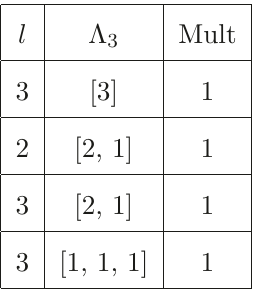
Table 2 . Results for n = 3 fields and k = 3 derivatives.